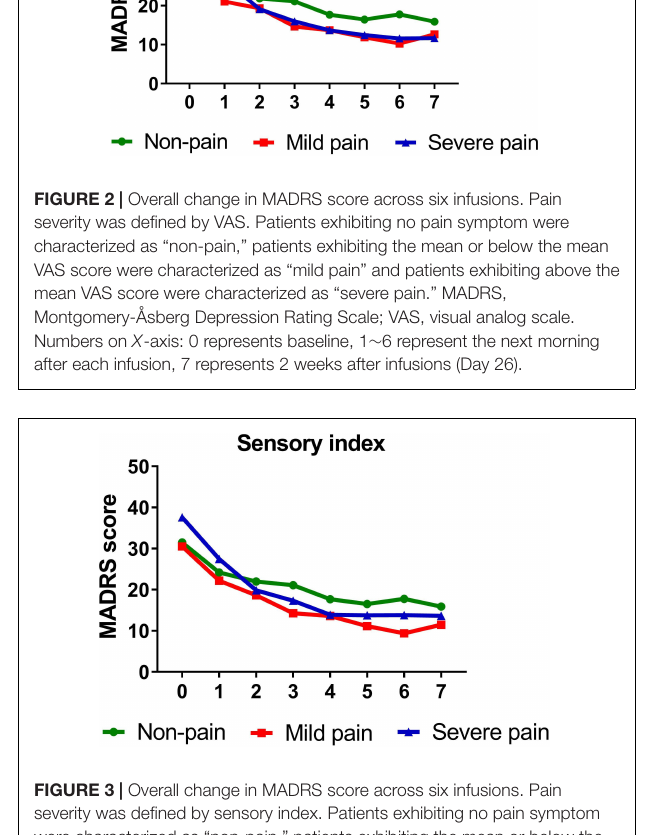
Similarly, participants with mild ( B = − 1.389, t = − 14.811,